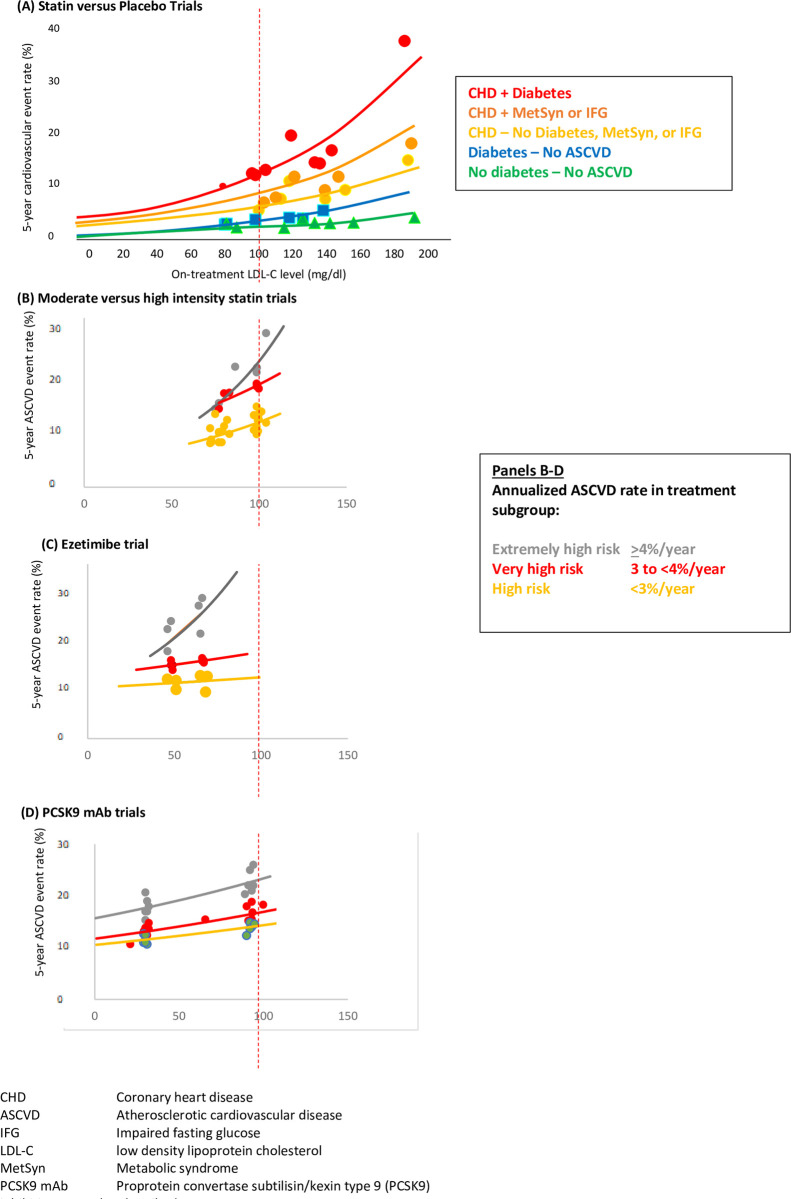
Achieved low density lipoprotein cholesterol (LDL-C) level and risk of cardiovascular disease (CVD) or atherosclerotic CVD (ASCVD) events by (A) subgroups from placebo-controlled statin trials of approximately a mean 5 years duration in the presence of coronary heart disease (CHD), metabolic syndrome (MS), impaired glucose tolerance (IGT) or diabetes (Adapted from Robinson JG, Stone NJ. Am J Cardiol 2006; 98:1405–1408); and subgroups categorized according to extrapolated 10-year ASCVD event rates from (B) moderate versus high intensity statin trials of a mean 3–5 years duration extrapolated to 5 years, and (C) PCSK9 inhibiting monoclonal antibody trials with a mean 2.2–2.8 years duration extrapolated to 5 years; Line represents log linear regression line for relationship between on-treatment LDL-C level and cardiovascular event rate weighted by group size.